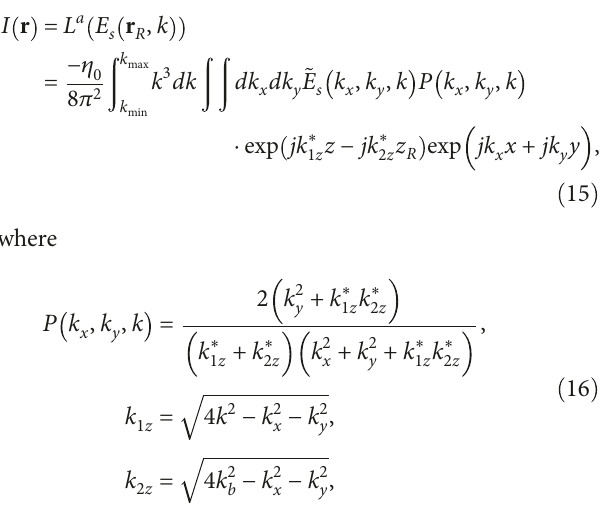
Figure 5: SFF of the reinforced wall versus antenna